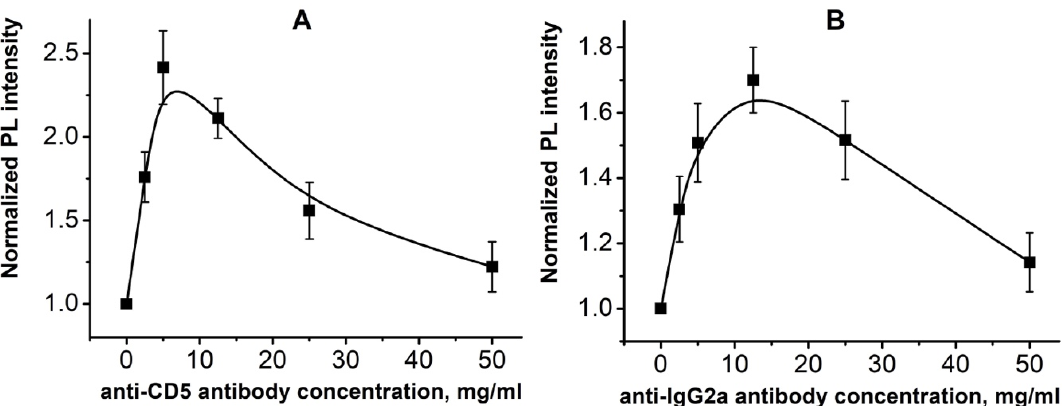
Figure 4. RT PL intensities of glass/ZnO NRs after immobilization of anti-CD5 ( A ) and anti-IgG2a ( B ) monoclonal antibodies in concentration ranges of 2.5–50.0 µg/mL.